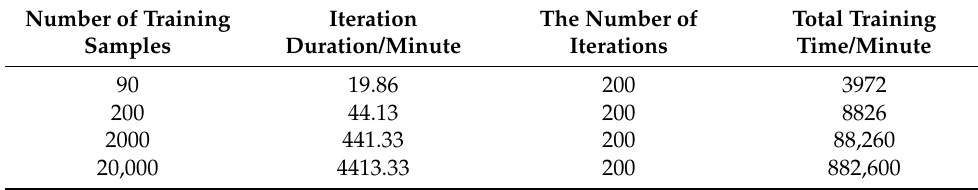
Table 2. Comparison of training time.